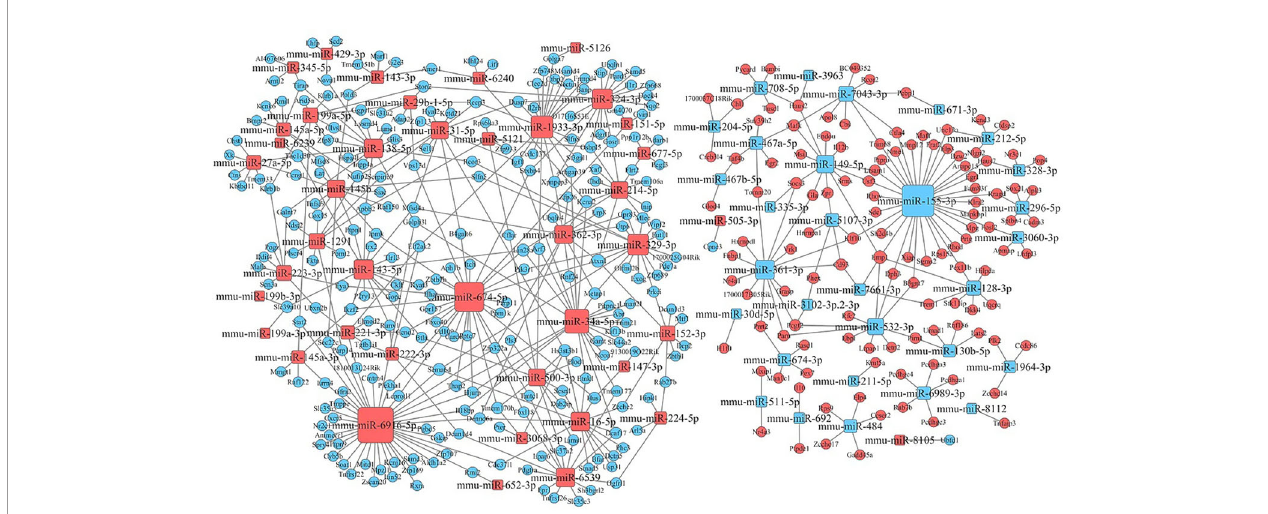
FIGURE 10 | miRNA – mRNA interaction network. The size of the point represents the regulatory capacity of a given miRNA. Squares indicate identi fi ed miRNAs, while circles represent the corresponding target genes. Blue indicates down-regulated miRNAs or mRNAs while red indicates up-regulated miRNAs or mRNAs. The relationship between miRNAs and genes is shown connected by gray